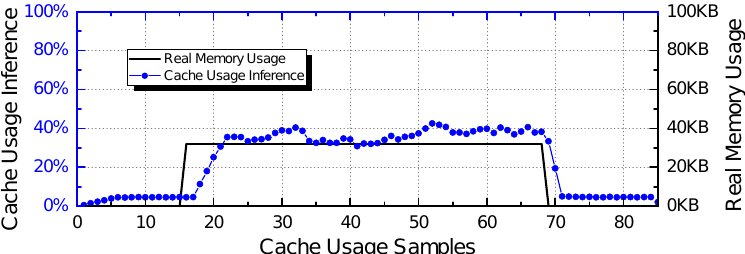
Figure 4. A demonstration of a cache-timing attack [48]. The x-axis is sample points and the y-axis shows both cache usage inference (round dots) and real memory usage amount (the solid line). It shows that a successful cache-timing attack can precisely infer the memory usage of the victim task.